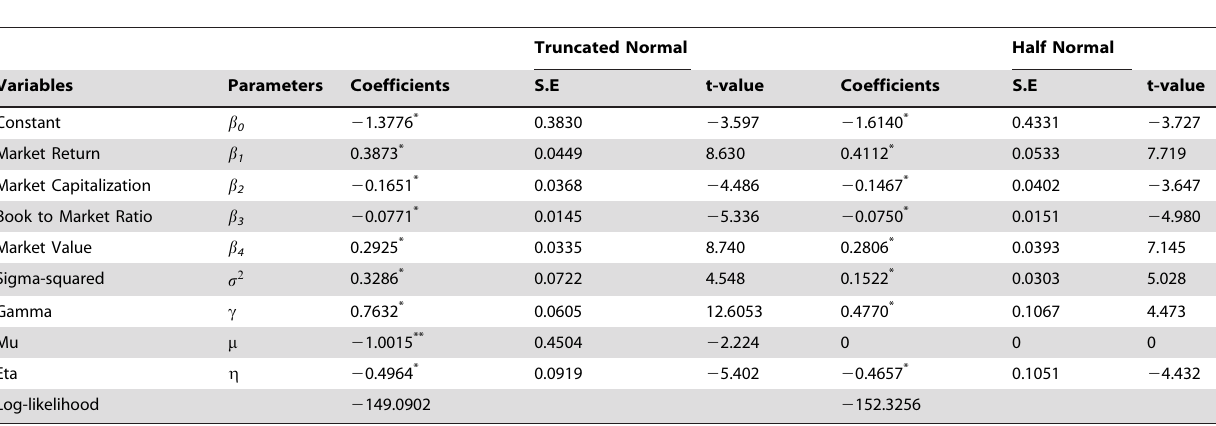
Table 2. Maximum-Likelihood Estimates of the Cobb-Douglas Stochastic Frontier Production Function with Time-variant.